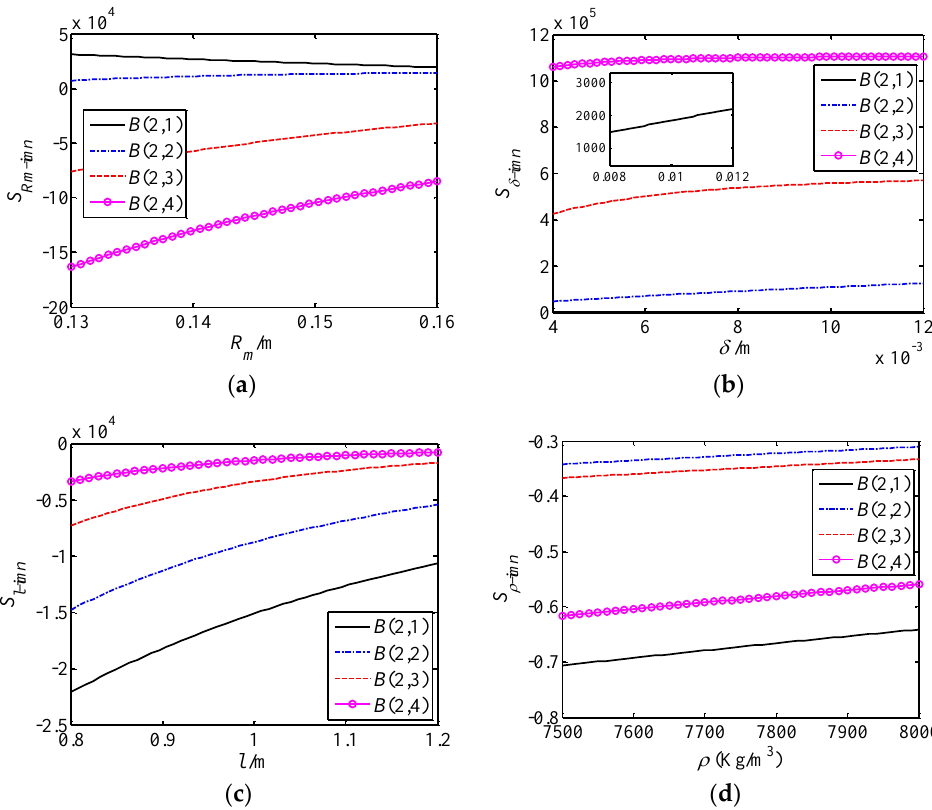
Figure 4. Frequency sensitivity with parameter changes. ( a ) R m changes; ( b ) δ changes; ( c ) l changes; ( d ) ρ changes.